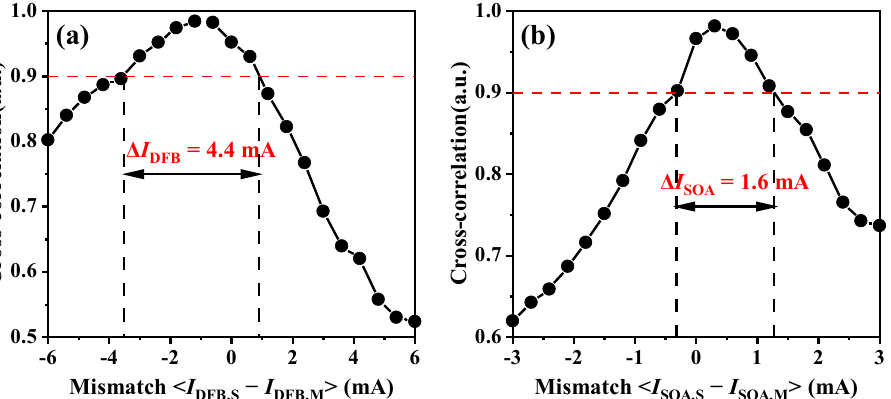
Figure 5. Influence of the bias current of ( a ) DFB laser section ( I DFB = 2 I th ) and ( b ) SOA section ( I SOA = 24 mA) mismatch on chaotic synchronization coefficients.